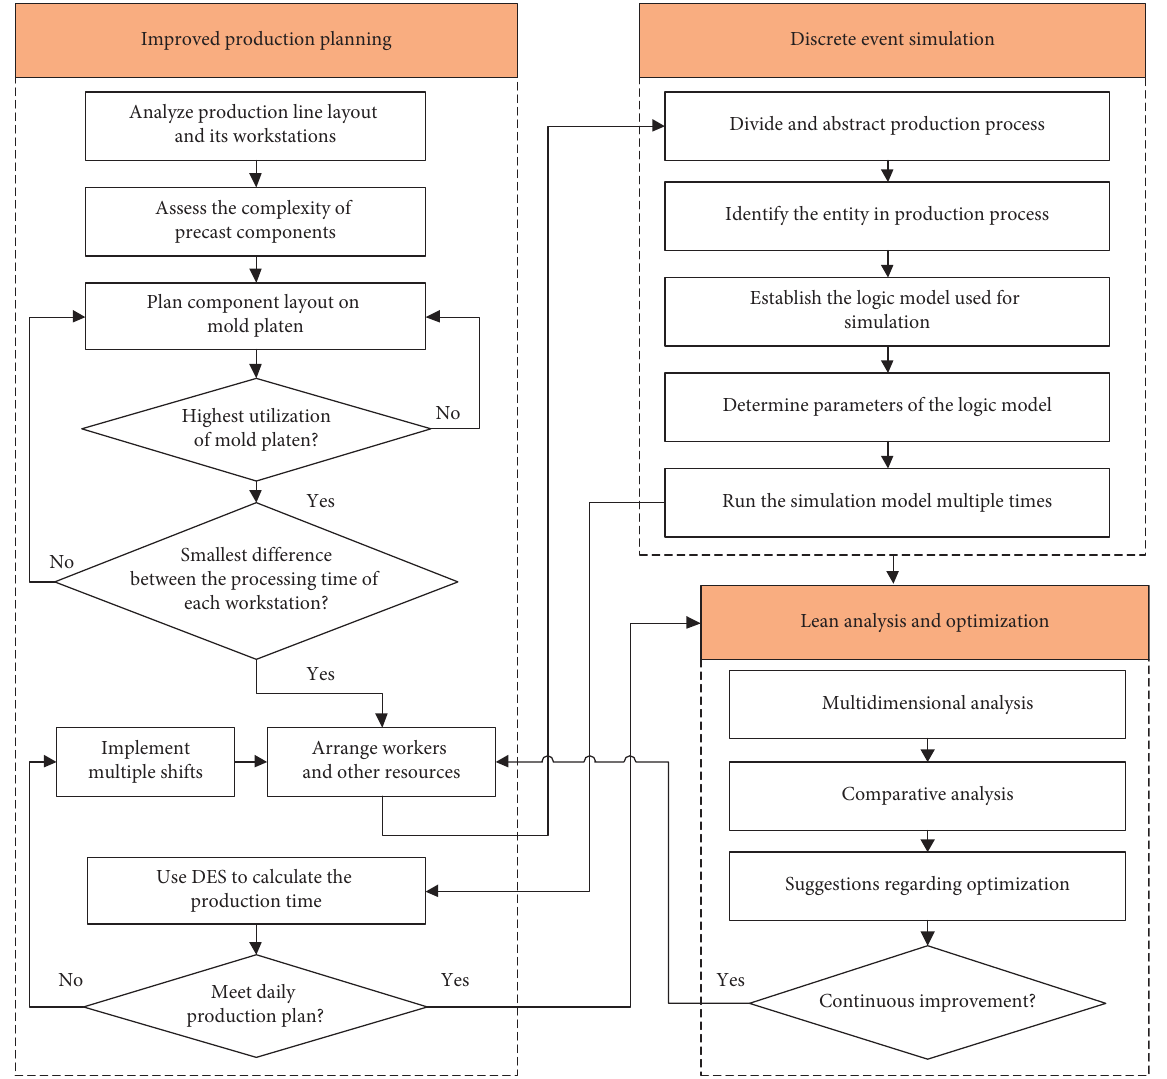
Figure 3: Framework for DES-based lean planning and optimization method. Table 2: Complexity evaluation index system for precast components produced by assembly